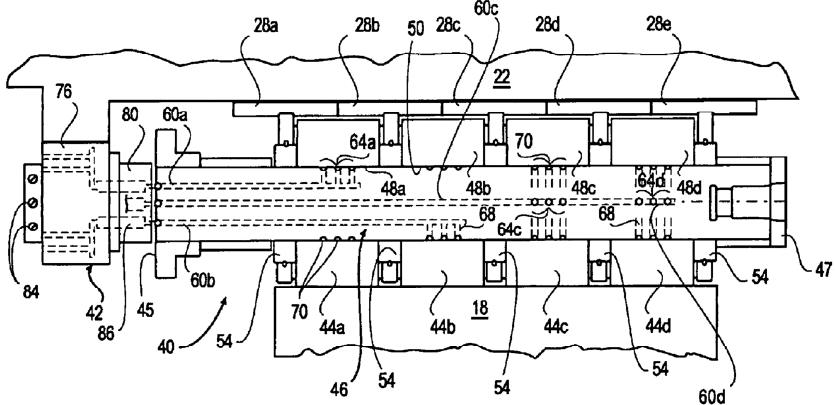
Figure 2. Back bearing assembly of a cluster mill [44].